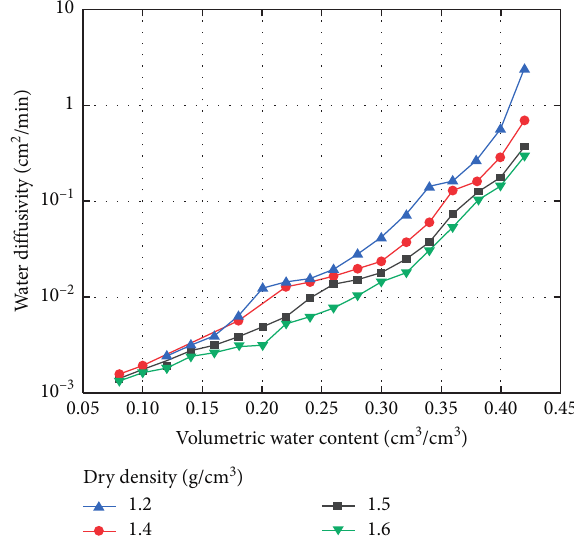
Figure 2: Water diffusivity of loess with dry density of 1.2, 1.4, 1.5, and 1.6g/cm 3 and volumetric liquid water content from 0.08 to 0.42cm 3 /cm 3